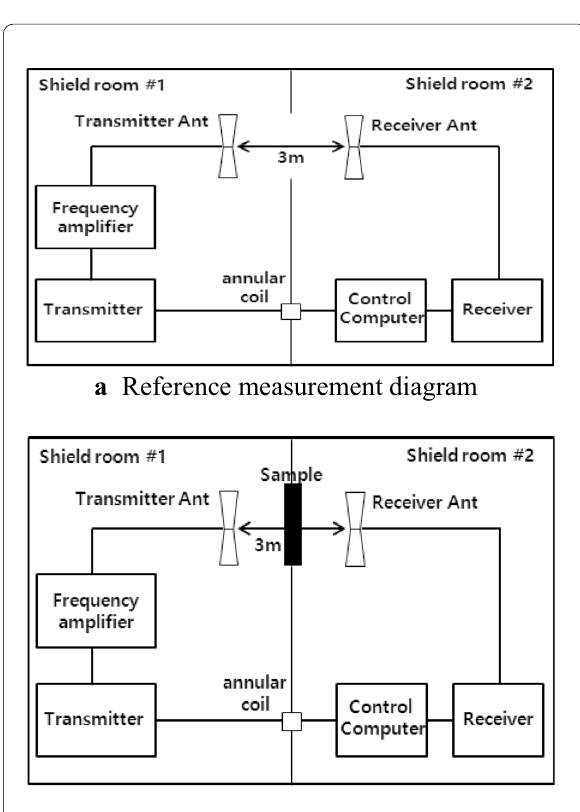
Fig. 4 EMP shield measurement concept.